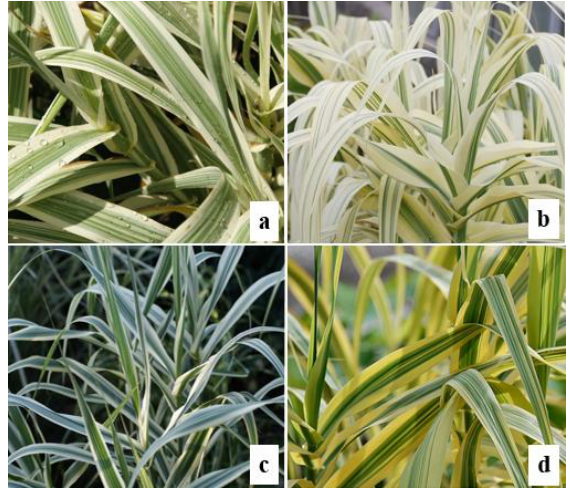
Figure 1. Varieties of striped giant reed in international trade Source : A) Arundo donax var. versicolor (Big Plant Nursery). B) ’Variegata superba’ (Future Gardens). C) ‘Variegata’ (Palm Exotics). D) ’Golden Chain’ (Water Plants Italy).